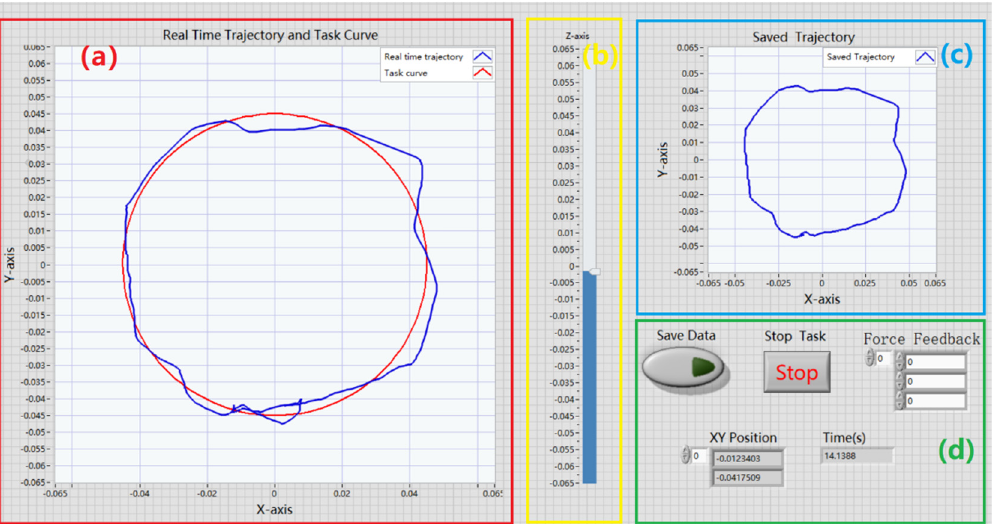
Figure 3. Data acquisition interface of the upper computer control system. ( a ) Real time trajectory and task curve in the experiment. ( b ) Z-axis of the spatial coordinate system. ( c ) Saved trajectory in the experiment. ( d ) the operation buttons and data output part of the upper computer control system.